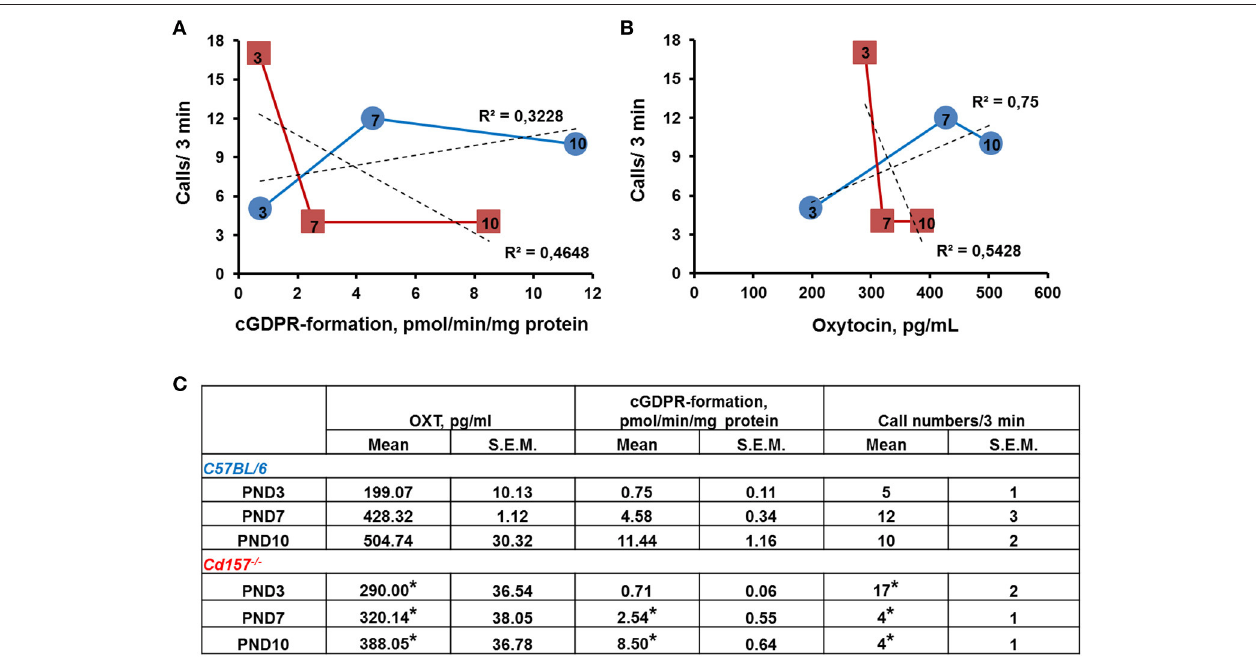
FIGURE 5 | ADP-ribosyl cyclase activity and plasma concentration of oxytocin in correlation with call number in Cd157 + / + and Cd157 − / − mice during 10 days of life. (A) ADP-ribosyl cyclase activity in relation to call number in Cd157 + / + (blue round) and Cd157 − / − (red squares) mice at post-natal days (PNDs) 3, 7, and 10. ADP-ribosyl cyclase activity was measured as rate of cyclic GDP-ribose formation in whole-cell homogenates isolated from the hypothalamus. (B) Plasma oxytocin (OXT) concentration correlates with call number in Cd157 + / + (blue round) and Cd157 − / − (red squares) mice at PNDs 3, 7, and 10. Data were obtained from pups at the indicated ages (arabic numbers). (C) Recorded ADP-ribosyl cyclase activity, plasma concentration of OXT, and call number in Cd157 + / + and Cd157 − / − mice at PNDs 3, 7, and 10. * P < 0.05 from Cd157 + / + pups at the corresponding measuring day.